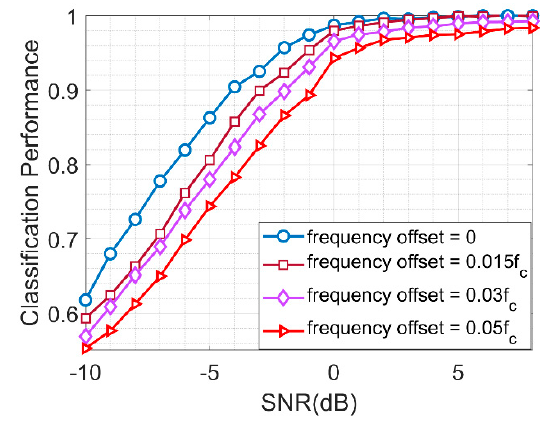
Figure 10. Performance of NSVM with Different Carrier Frequency Offset in received signal.